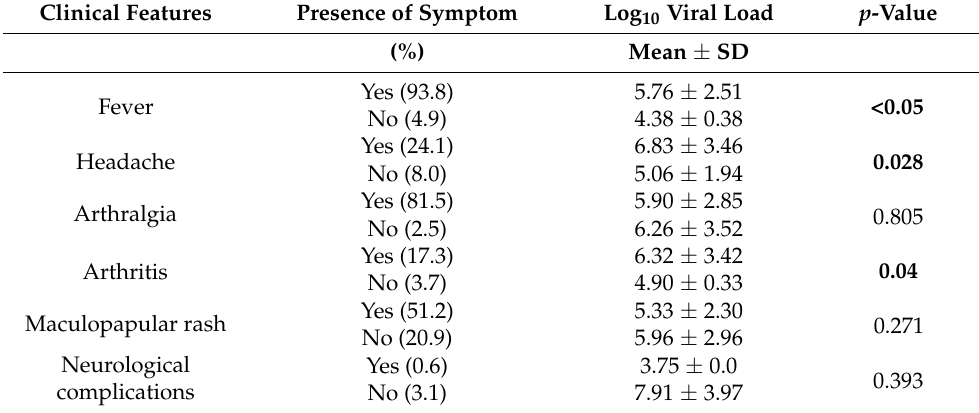
Table 3. Association of viral load and clinical features among CHIKV-infected patients (N = 162). Clinical Features